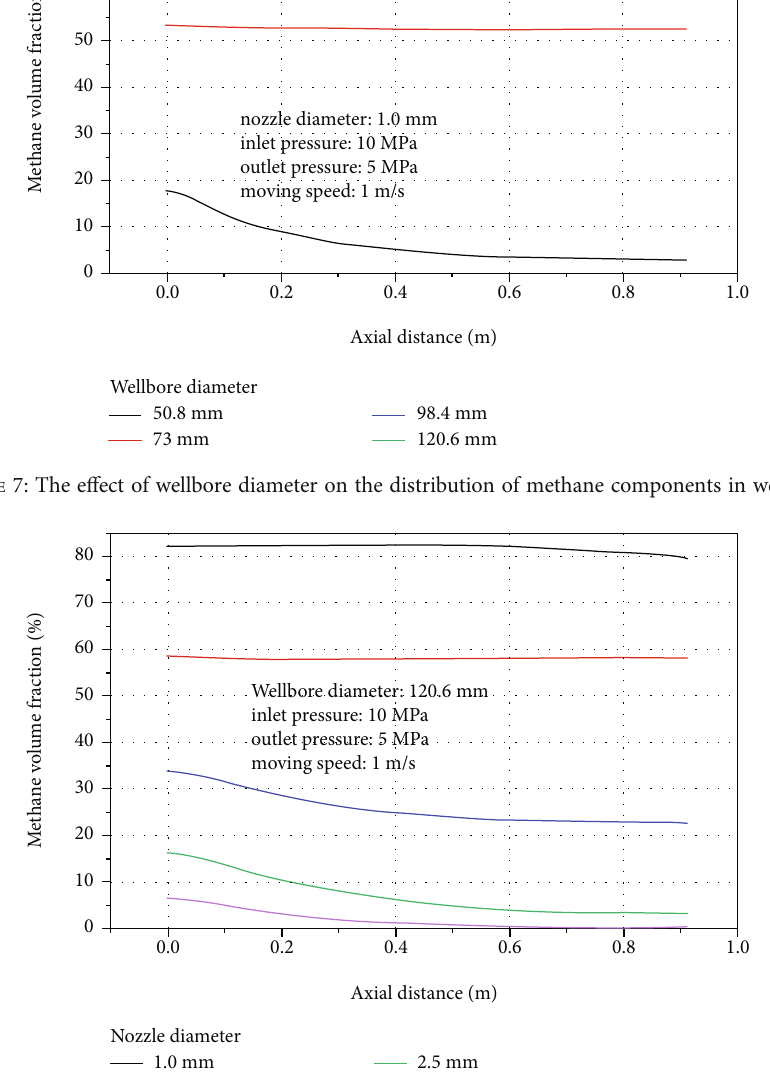
Figure 8: The e ff ect of nozzle diameter on the distribution of methane components in